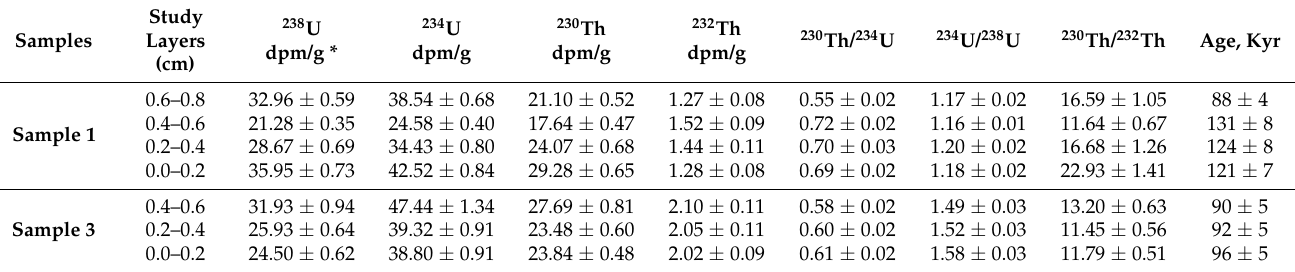
Table 1. Results of radiochemical analysis of the samples 1 and 3.